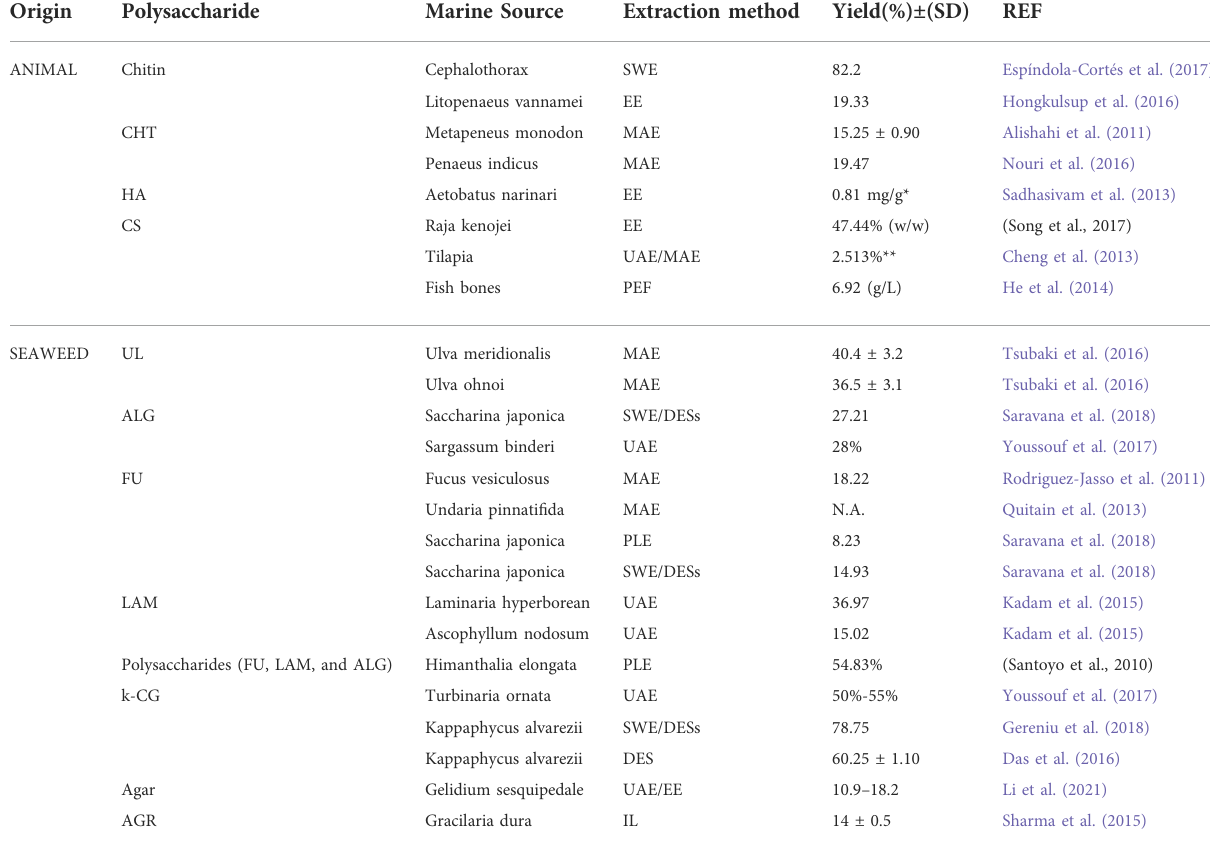
TABLE 2 Green extraction techniques applied to recovery polysaccharides from marine raw